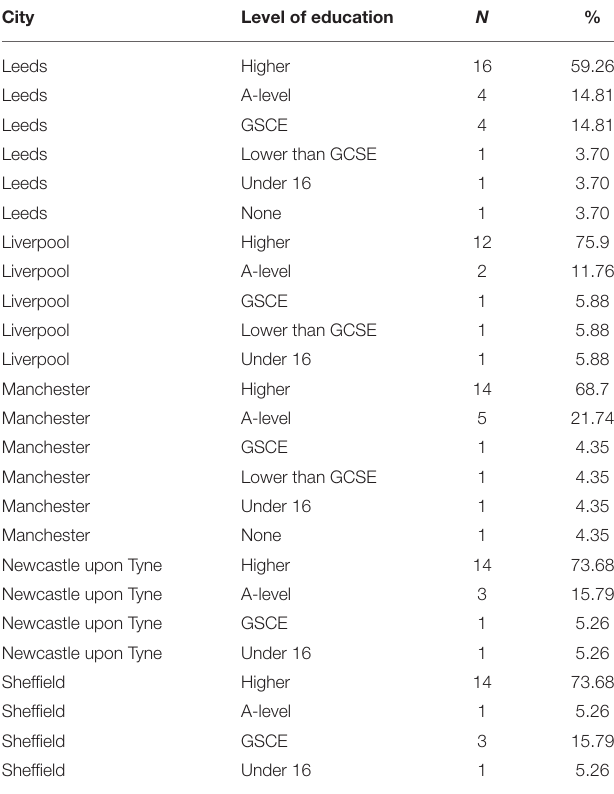
TABLE 3 | Summary of education by city in our speaker